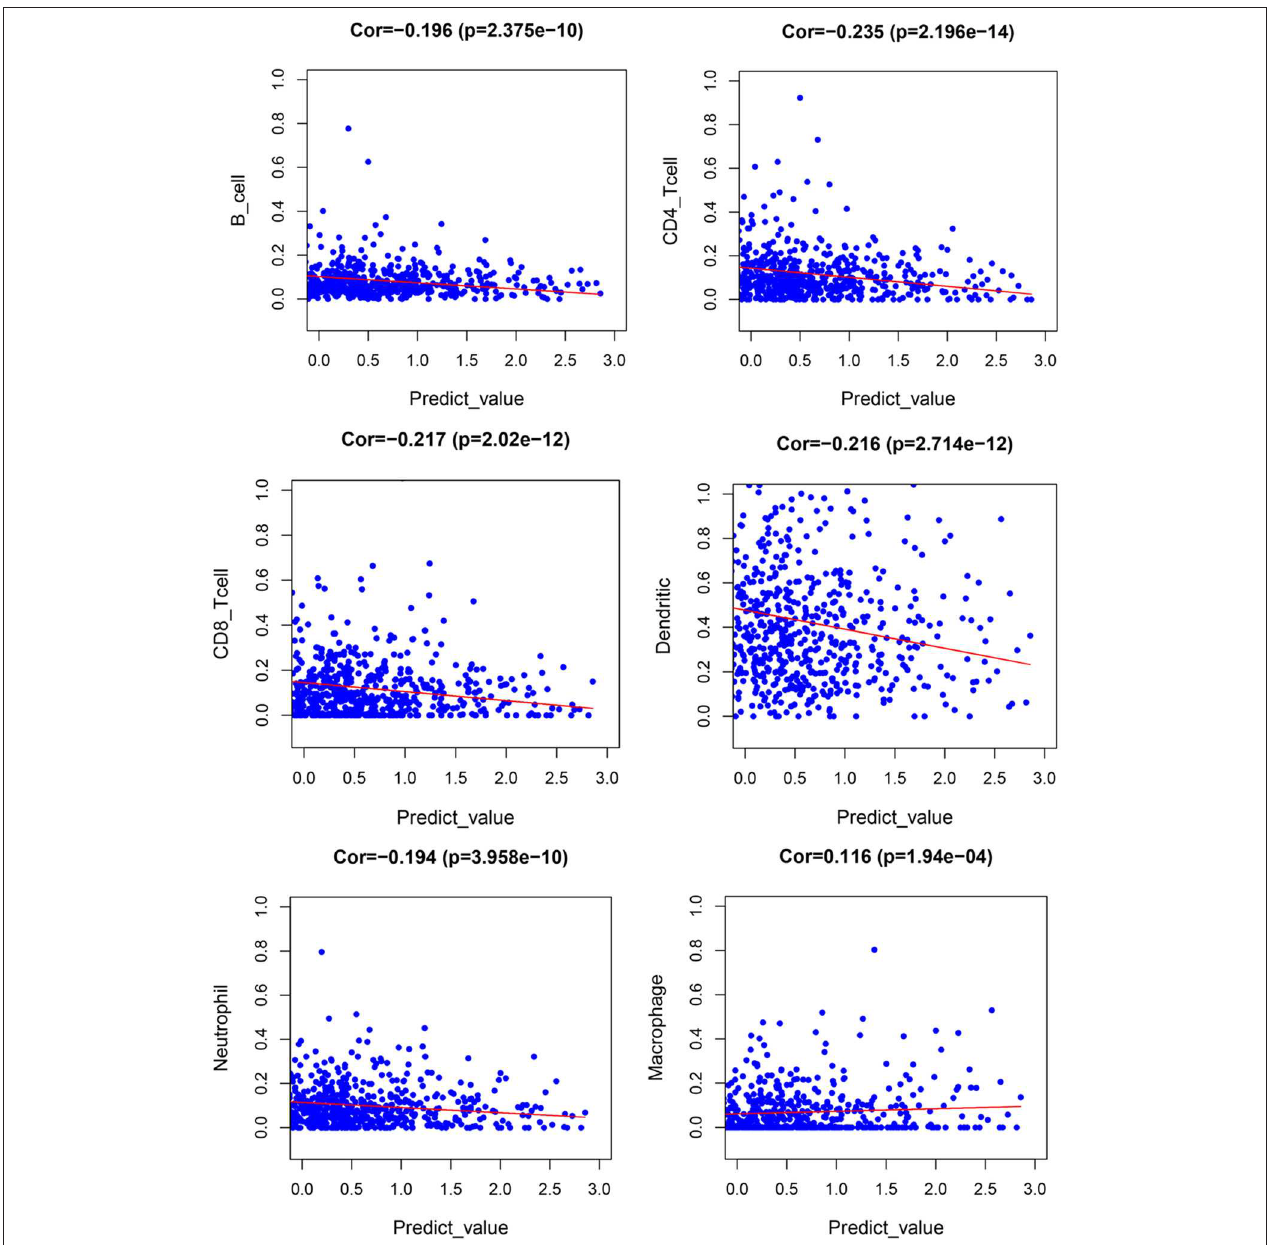
FIGURE 12 | Scatterplot of tumor-infiltrating immune cells and prognostic